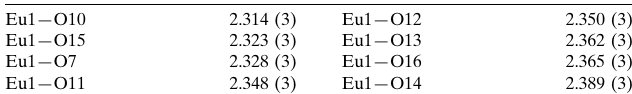
Selected bond lengths (A˚ ).